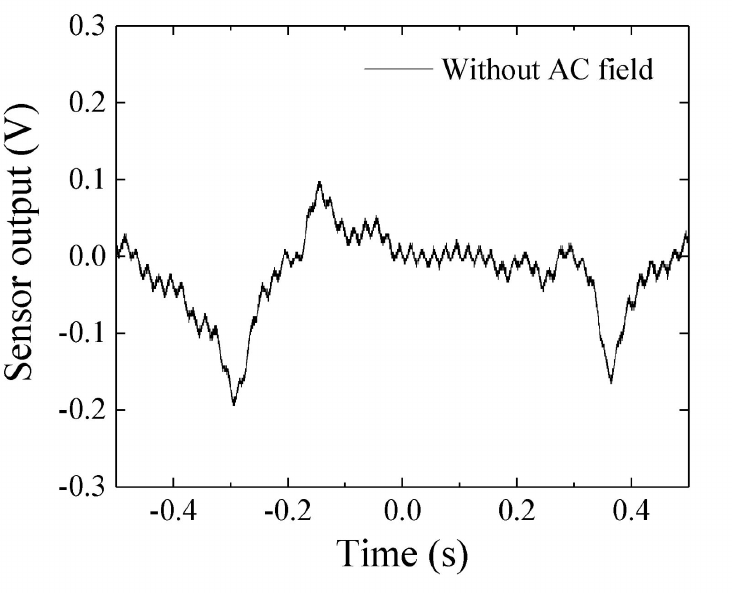
Figure 20. The 0.2 V periodical dipping noise of the sensor’s driver circuit